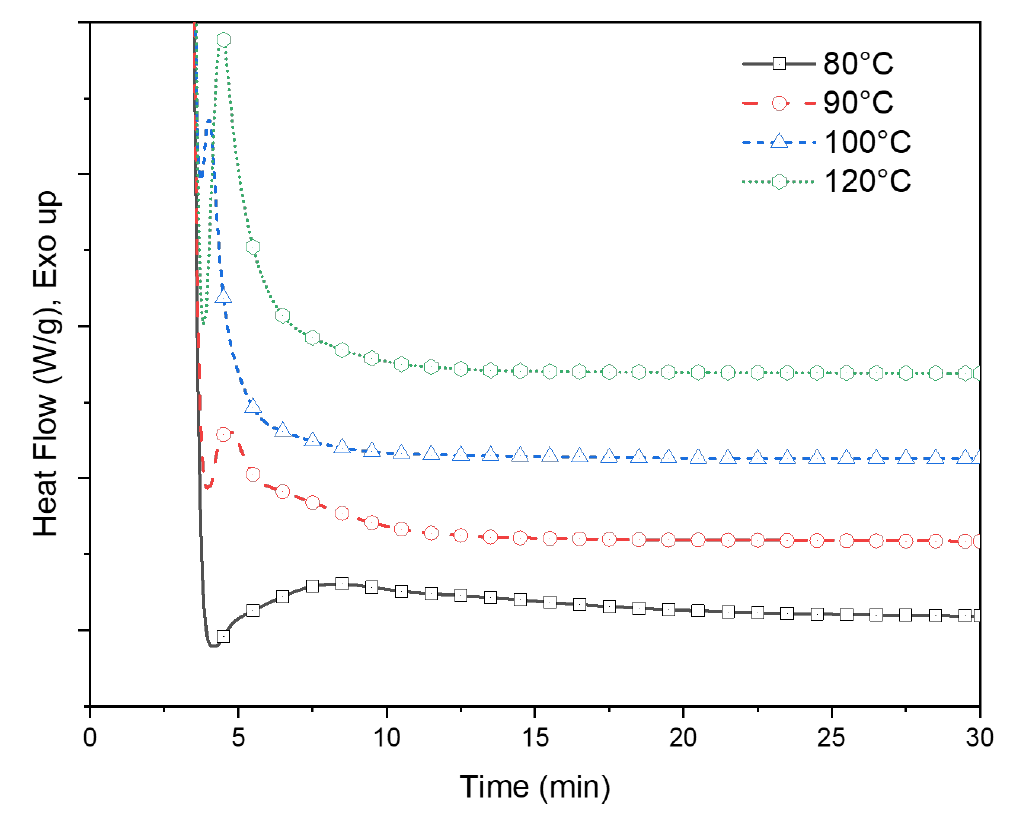
Figure 3. Heat flow data of PLA-OA blend isotherm tests at 80 °C, 90 °C, 100 °C, and 120 °C.